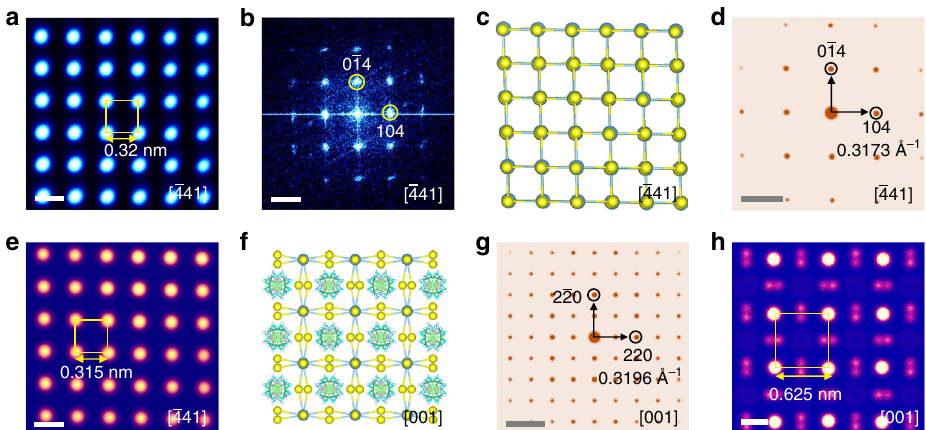
Fig. 3 Structure and ED difference between PbI 2 and tetragonal MAPbI 3 . a A STEM image of PbI 2 viewing along the [ (cid:1) 441] direction, judged from b the corresponding FFT pattern. c The atomic ball-and-stick model, d the simulated ED pattern, and e simulated STEM image of PbI 2 along the [ (cid:1) 441] zone axis. f The atomic ball-and-stick model, g the simulated ED pattern, and h simulated STEM image of MAPbI 3 along the [001] zone axis. The ED patterns of PbI 2 and MAPbI 3 are similar with a slight difference that the {2h + 1, 2h + 1, 0} re fl ections [e.g., (110)] of MAPbI 3 are not observed in that of PbI 2 . Besides, the distance between two brighter atoms is 0.625 nm for MAPbI 3 , which is about twice the distance between two brighter atoms (0.315 nm) of PbI 2 . Scale bar, 0.3 nm ( a , e , h ); 3 nm − 1 ( b , d , g